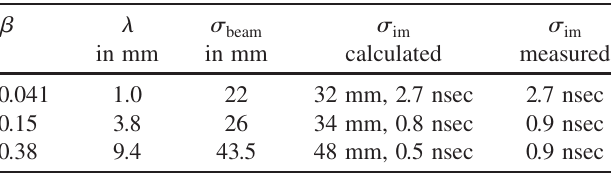
TABLE I. The measured values are the temporal length of a base bunch seen by the capacitive probe. The base length is divided by 5.5 to obtain the rms value. The measurement was done by the Lecroy 7300A scope connected to the high imped- ance preamplifier output. It is known to have a limited band- width; therefore a measurement of bunch length < 5 nsec (equivalent to 0.9 nsec) cannot be performed.